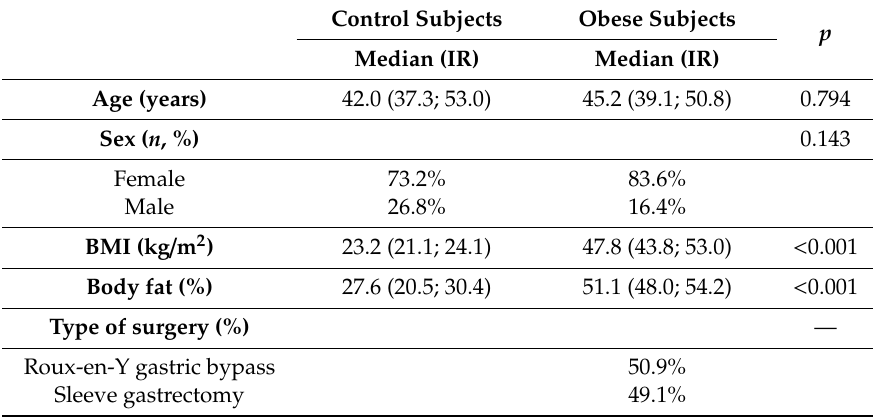
Table 1. Preoperative characteristics of the obese patients and the control